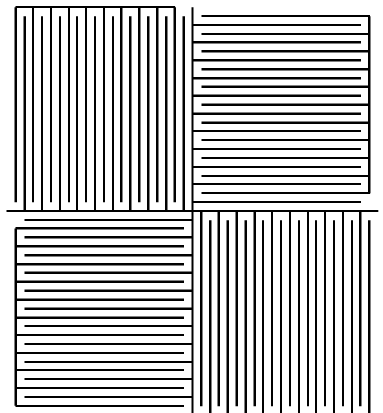
Figure 13. Resistance bridge with conductive bands forming a 90° angle between